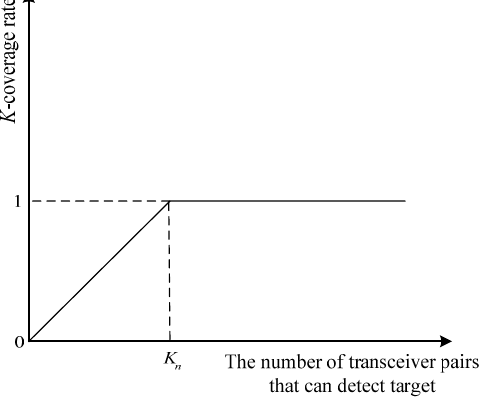
Figure 1. The curve of the K -coverage rate.